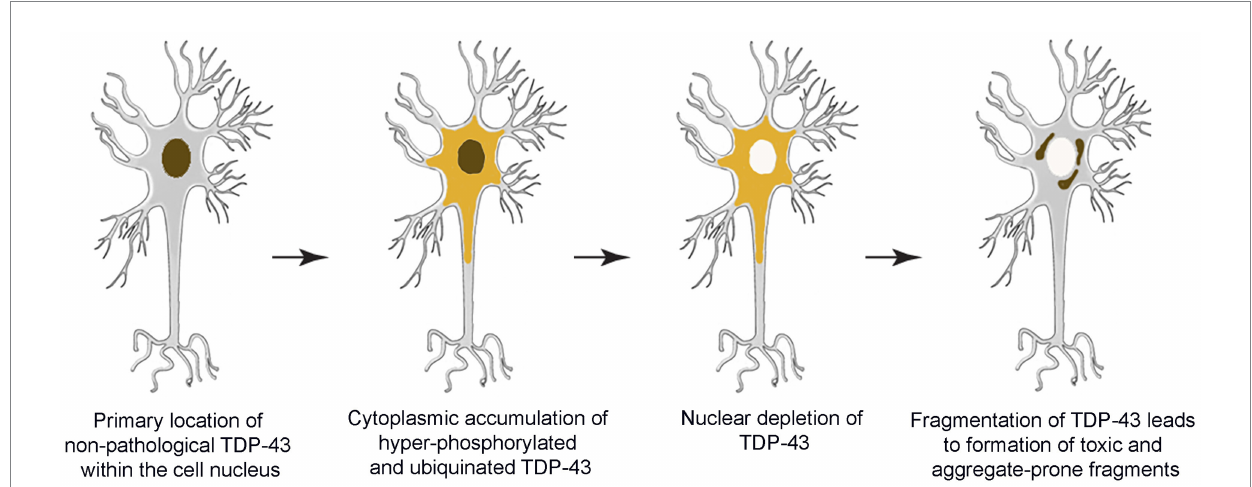
FIGURE 1 Schematic overview depicting progressive development of TDP-43 pathology within the